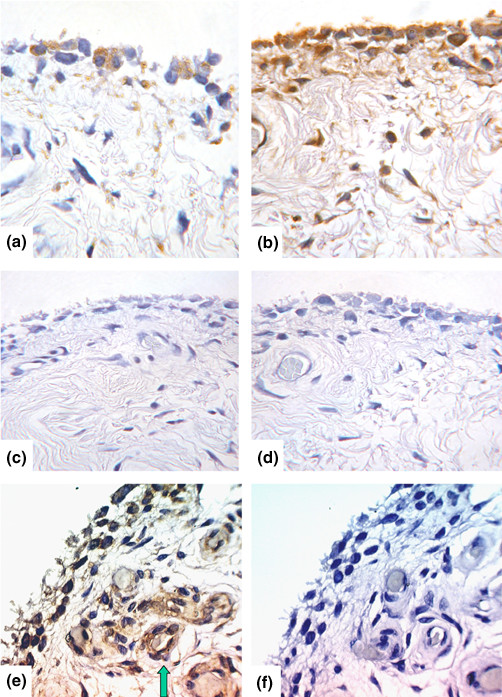
Immunohistochemistry of CXCR5 in non-rheumatoid arthritis synovia. (a) CD68 staining in the intimal layer. (b) Serial section to (a) treated with anti-CXCR5, showing that CXCR5+ cells in the intimal layer included those also positive for CD68. (c) and (d) Sections from the same region as (a) and (b), treated with isotype-matched control immunoglobulin instead of CD68 and CXCR5 antibodies, respectively. (e) Subintimal postcapillary venule stains for CXCR5 expression (arrow). (f) Isotype-matched control for (e). Labelling was revealed using 3,3'-diaminobenzidine substrate. (a), (b), (e) and (f) Original magnification, 420 ×; (c) and (d) original magnification, 350 ×.